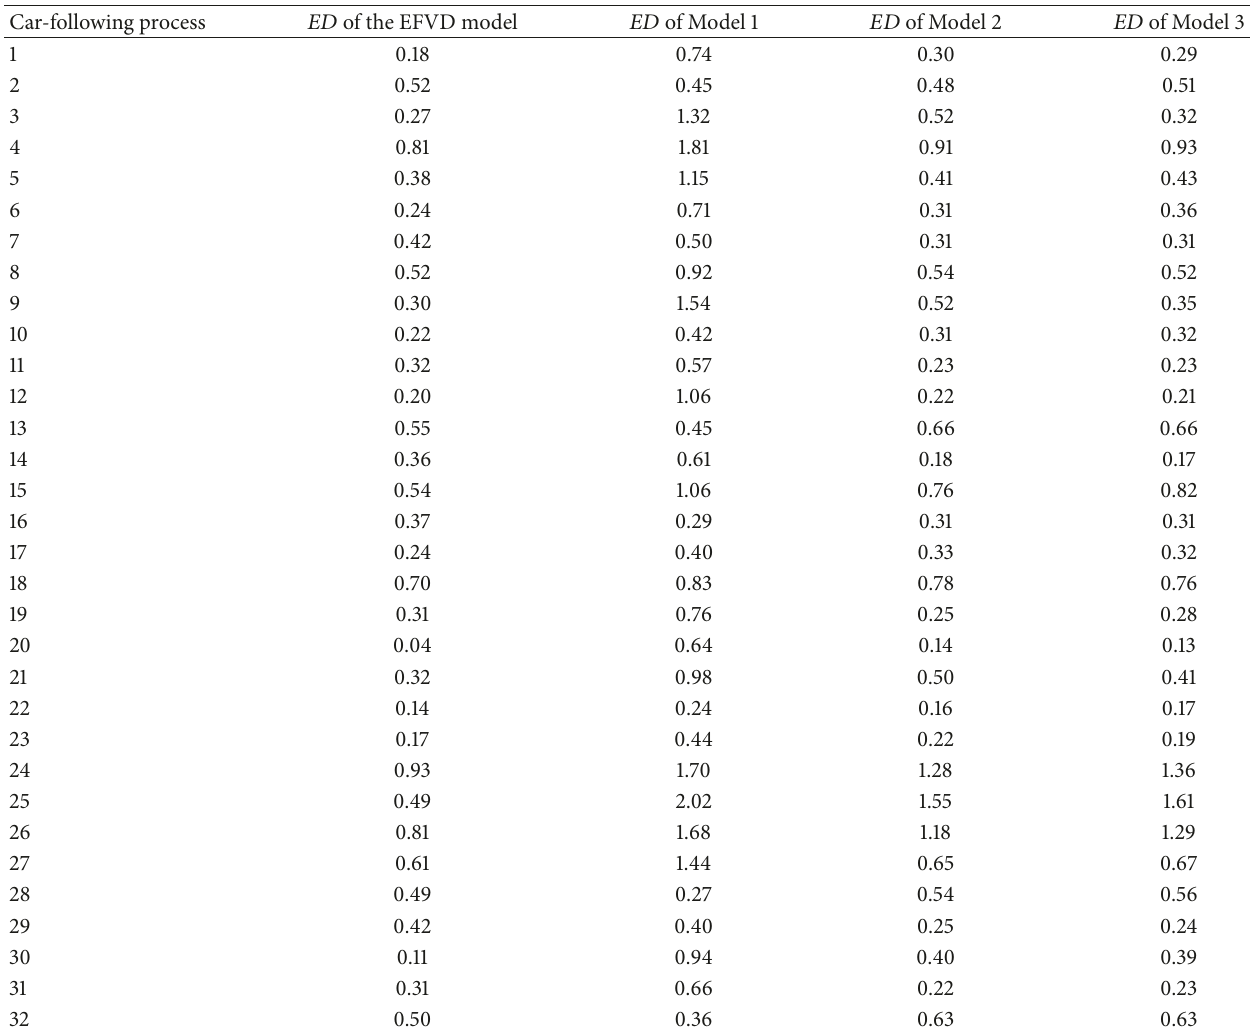
Table 3: 𝐸𝐷 of the different